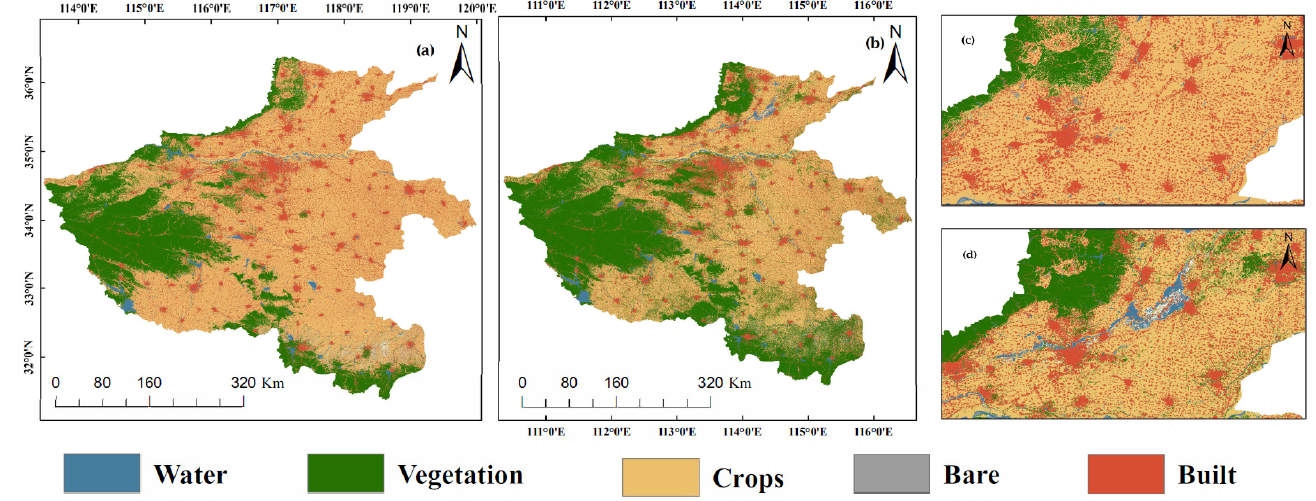
Figure 4. Analysis and comparison of the affected areas before and after flooding in Henan Province. ( a ) is pre-flood classification result, ( b ) is post-flood classification result, ( c ) is pre-flood local ampli- fication result, ( d ) is post-flood local amplification result.